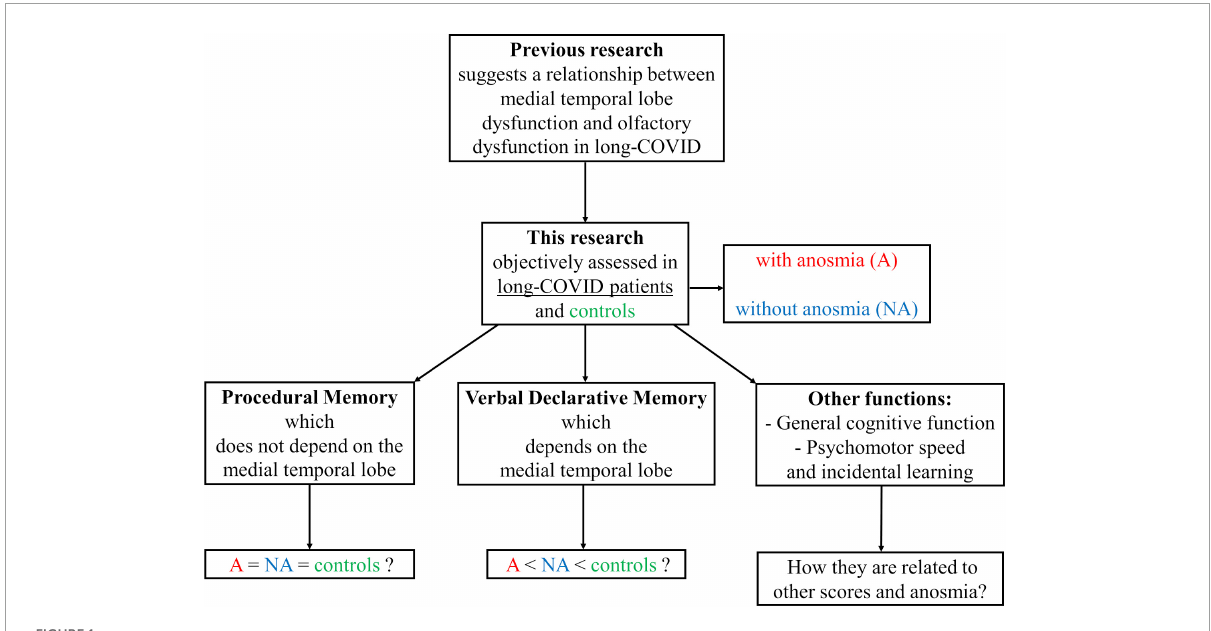
FIGURE1 Research hypothesis